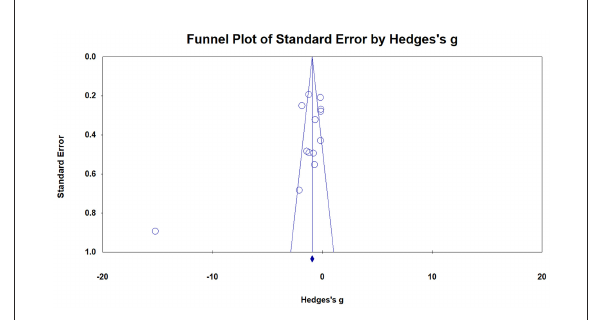
FIGURE3 Funnel plot of articles on HT intervention and depression scores in the